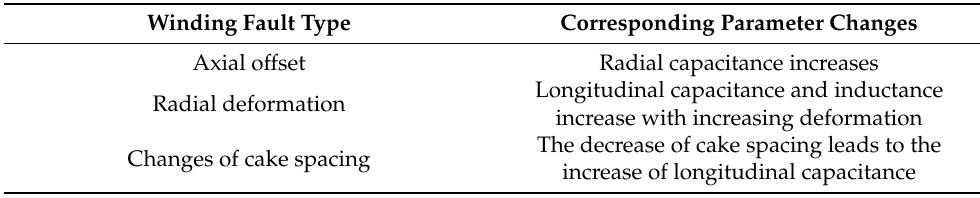
Table 5. Changes of winding deformation corresponding parameters.